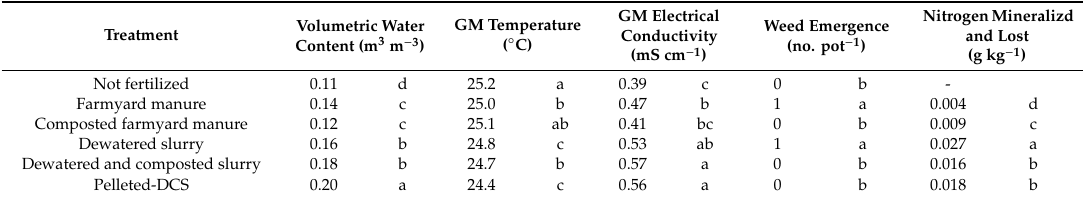
Table 3. Parameters investigated in the potting experiment using raw and processed livestock manures as organic